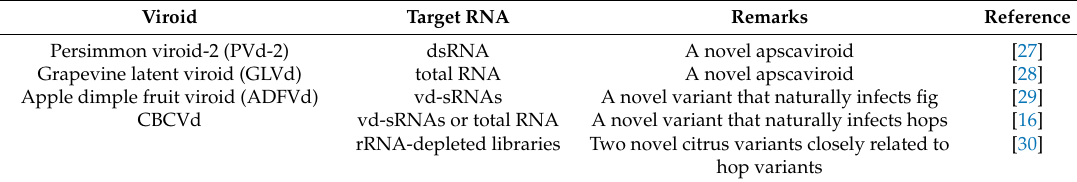
Table 1. Discovery of novel viroids or variants by NGS.